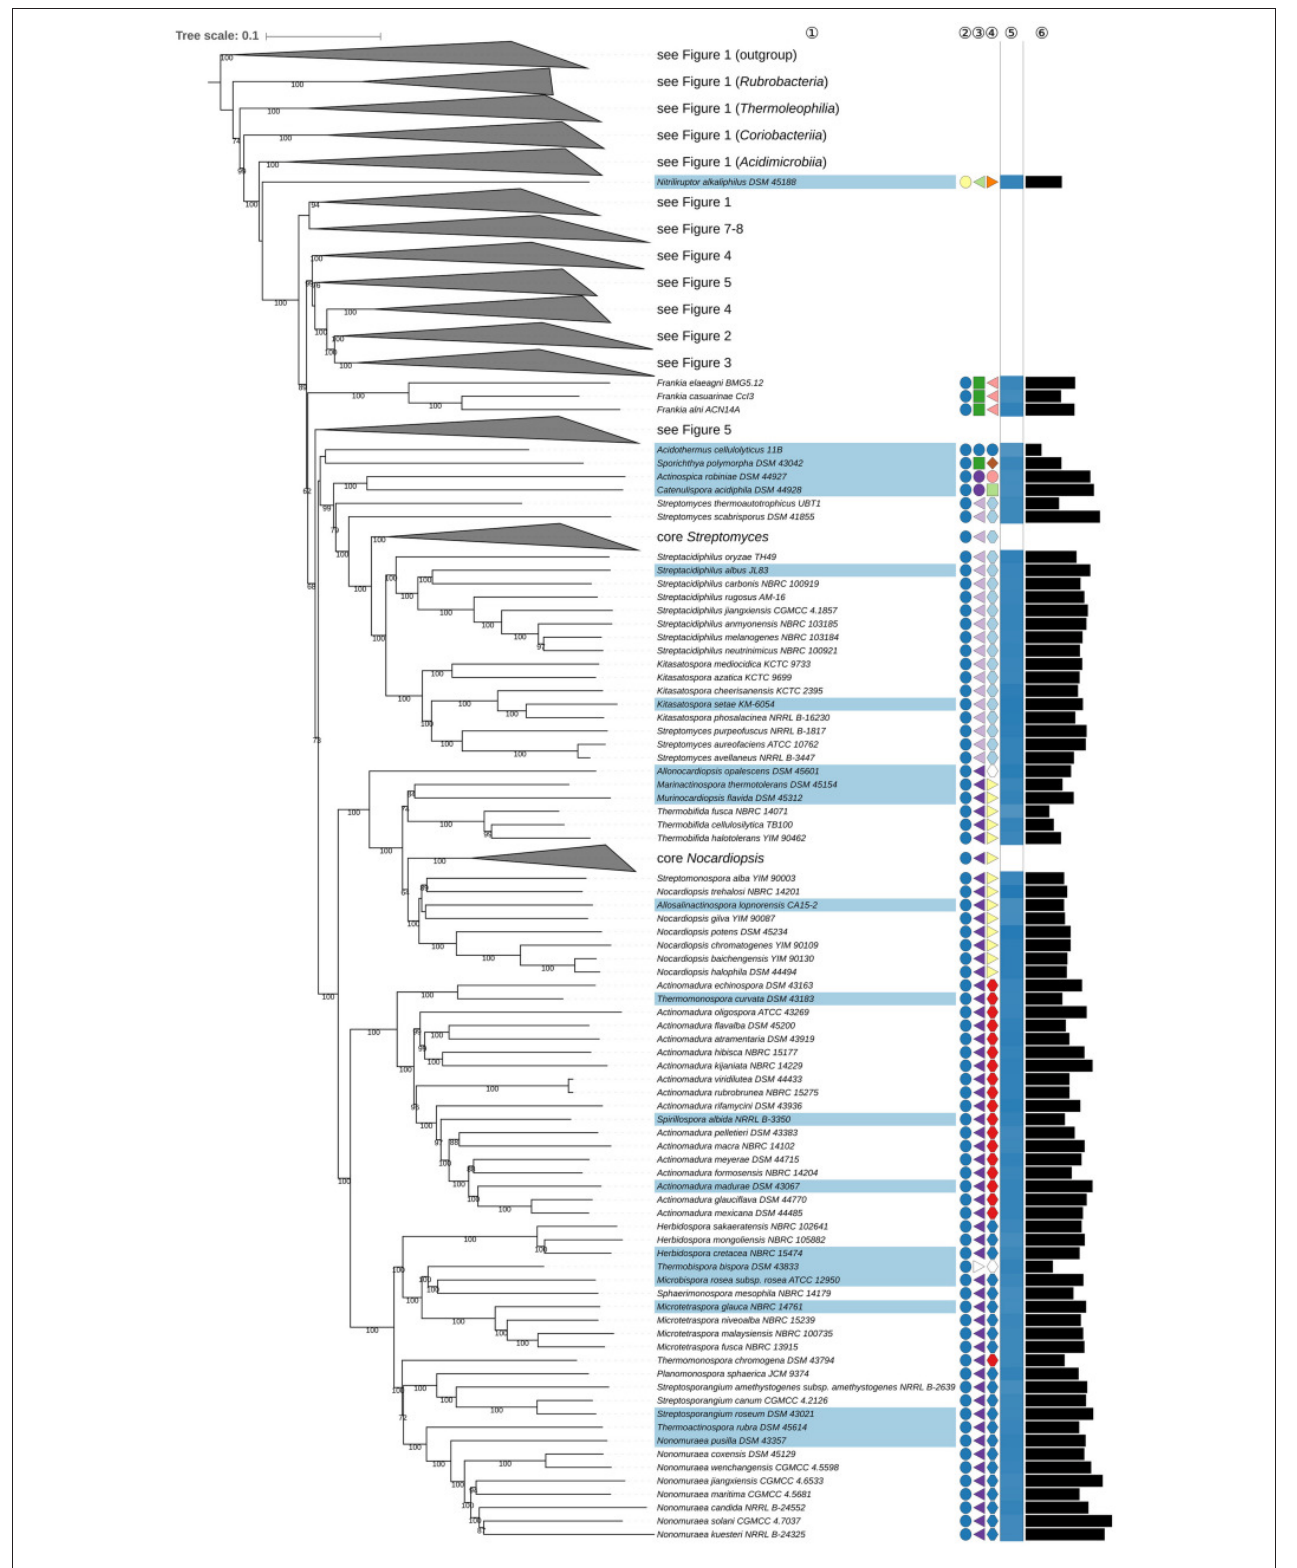
FIGURE 6 | Sixth part of the phylogenomic tree inferred with GBDP. A detailed description is provided in the caption of Figure 1 . The parts of the tree which have been collapsed here are shown in other figures as indicated.